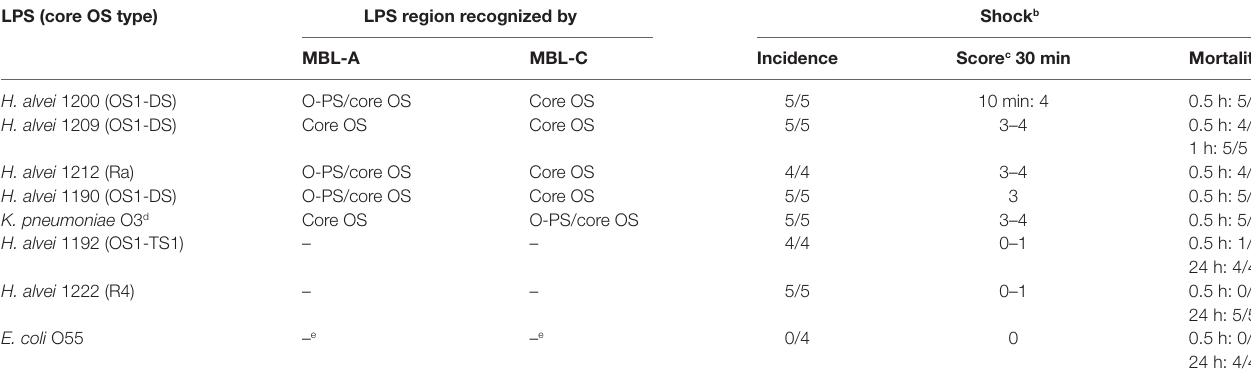
TaBle 2 | Ability of LPS from smooth strains of Hafnia alvei , E. coli , and Klebsiella pneumoniae to induce anaphylactoid shock and death in BALB/c mice. a